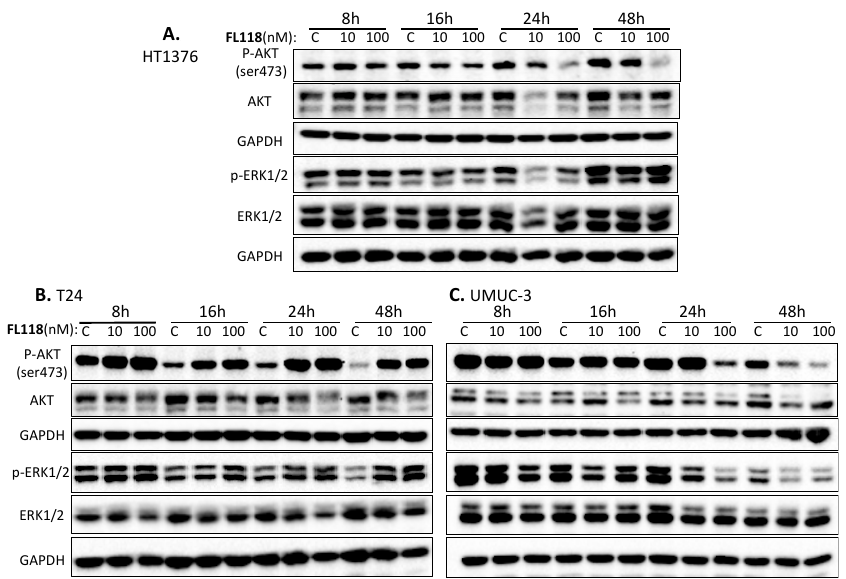
Figure 4. Effect of FL118 on AKT and ERK1/2 expression and phosphorylation/activation in bladder cancer cells. Subconfluent bladder cancer cells were treated with (10, 100 nM) and without (C, control/vehicle) FL118 for 8 h, 16 h, 24 h and 48 h, as shown, followed by Western blot analyses to determine the expression of AKT and ERK1/2 as well as the phospho-AKT (ser473) and phospho-p44/42 MAPK (ERK1/2) (Thr202/Tyr204). ( A ) Treatment of HT1376 cells with FL118 does not significantly modulate the expression and phosphorylation of Erk1/2. At the same time, FL118 reduces the expression of pAKT (ser473). ( B ) Treatment of T24 cells with FL118 enhances the phosphorylation of Akt and Erk1 / 2. ( C ) Treatment of UMUC-3 cells with FL118 downregulated the expression of active AKT and ERK1 / 2. GAPDH presented in ( A – C ) is internal controls for total protein-loading. 3.5. Inhibition of Top1 Expression Is Independent of FL118 Sensitivity or Resistance in Bladder Cancer